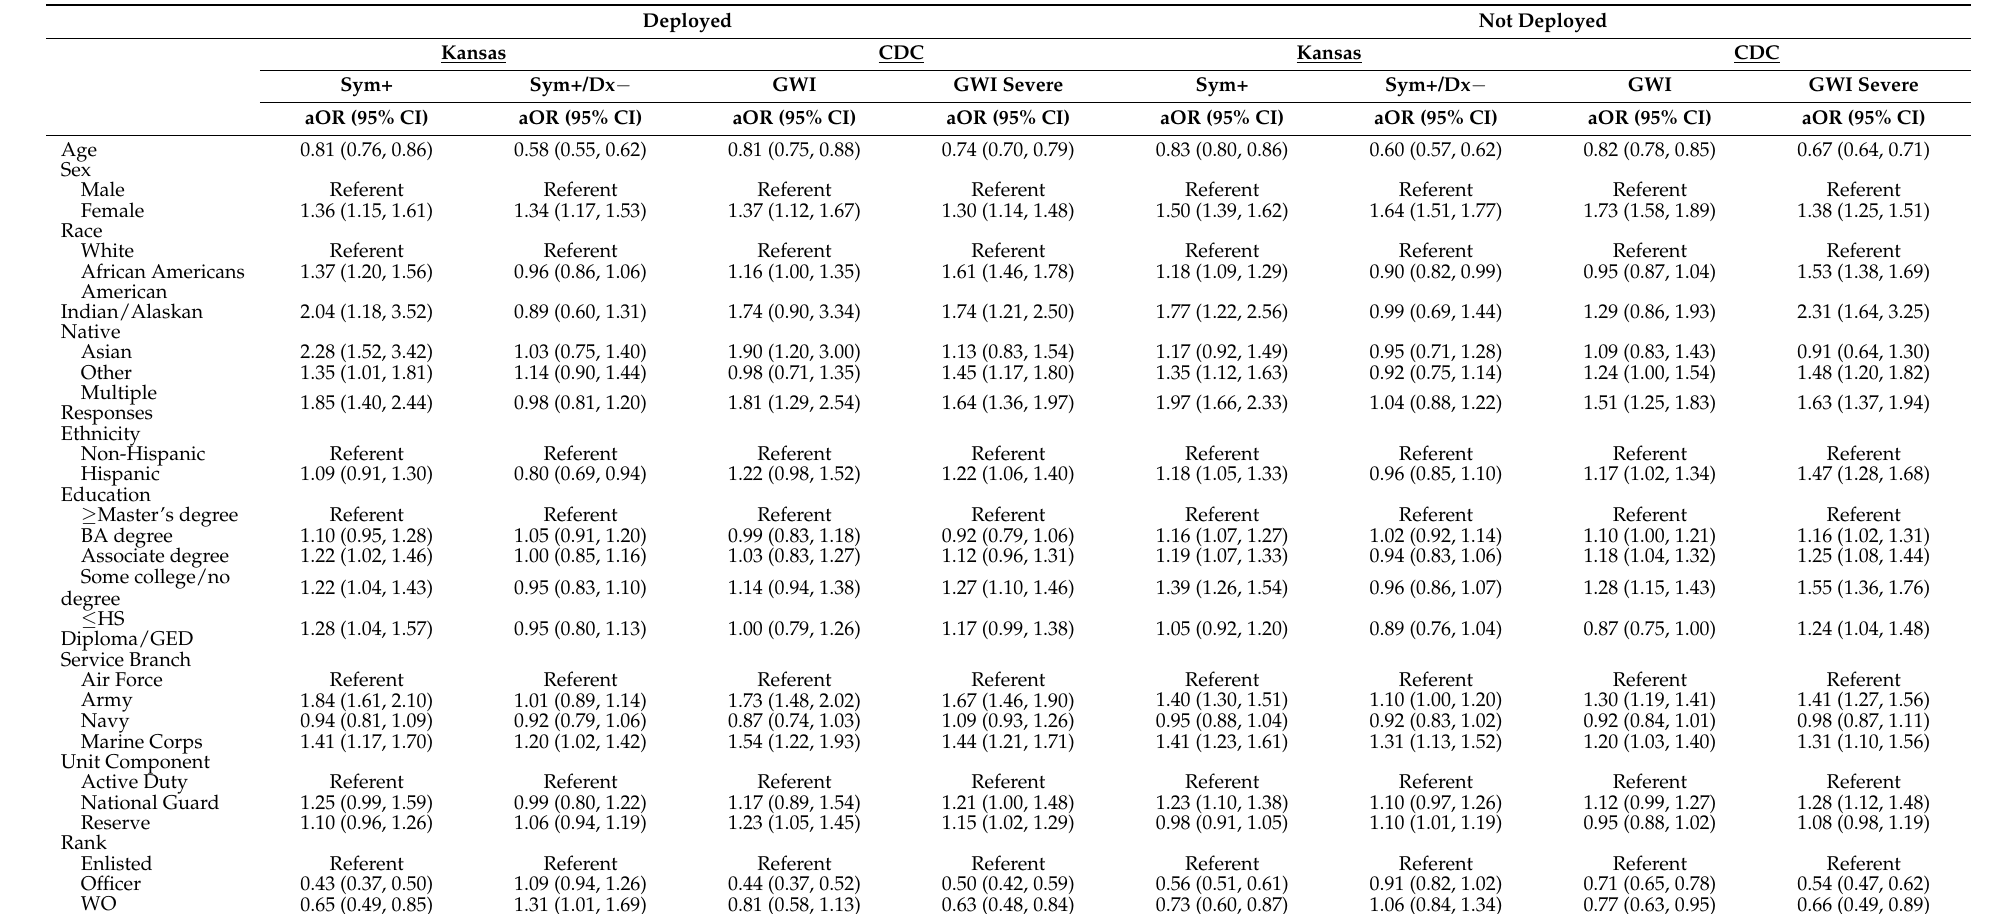
Table A3. Adjusted Associations of Gulf War Illness Phenotypes with Demographic Characteristics. Deployed Not Deployed Kansas CDC